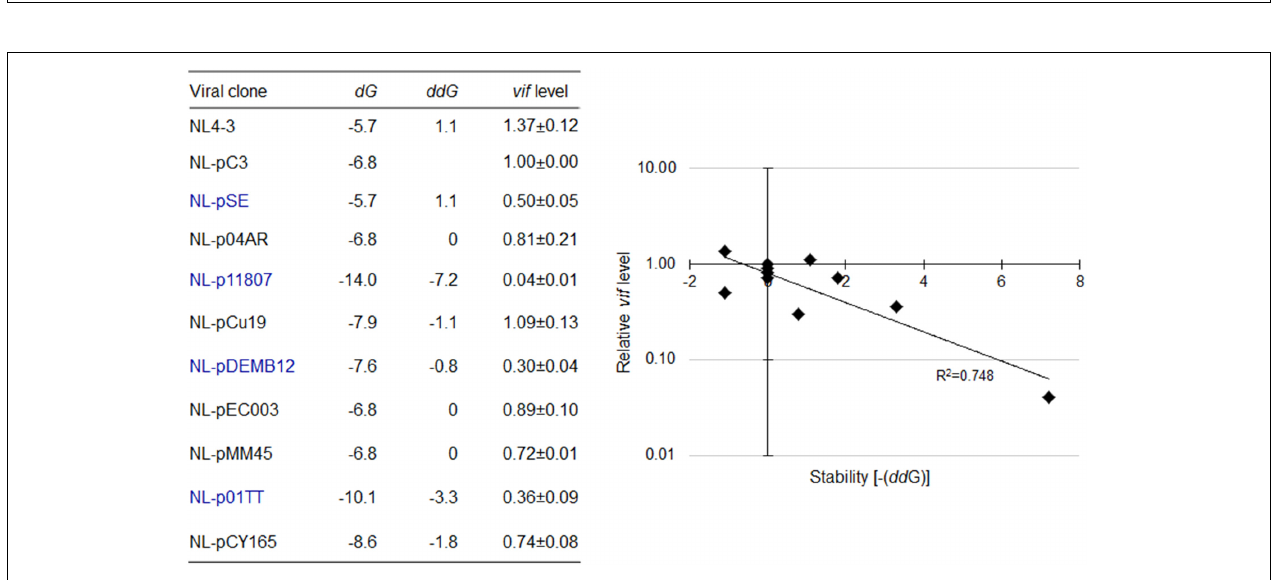
FIGURE 14 | Relationship between vif mRNA production and SLSA1 RNA stability for clones carrying naturally occurring full-length SA1D2prox sequences. Free energy ( d G) for SLSA1 sequence derived from proviral clones indicated were predicted by mfold program (Zuker, 2003). RNA stability ( dd G) is presented as difference of free energy between NL4-3/each nSNV and NL-pC3. Relative vif expression levels to that by NL-pC3 in Figure 12 were used. Blue letters indicate clones that gave vif expression levels significantly lower than that by NL-pC3. Scatter diagram on the right was created by plotting vif expression levels and SLSA1 stabilities [–( dd G)] of the clones relative to those of NL-pC3. Exponential trendline and coefficient of determination ( R 2 = 0.748, p = 0.019 by F -test) are shown.